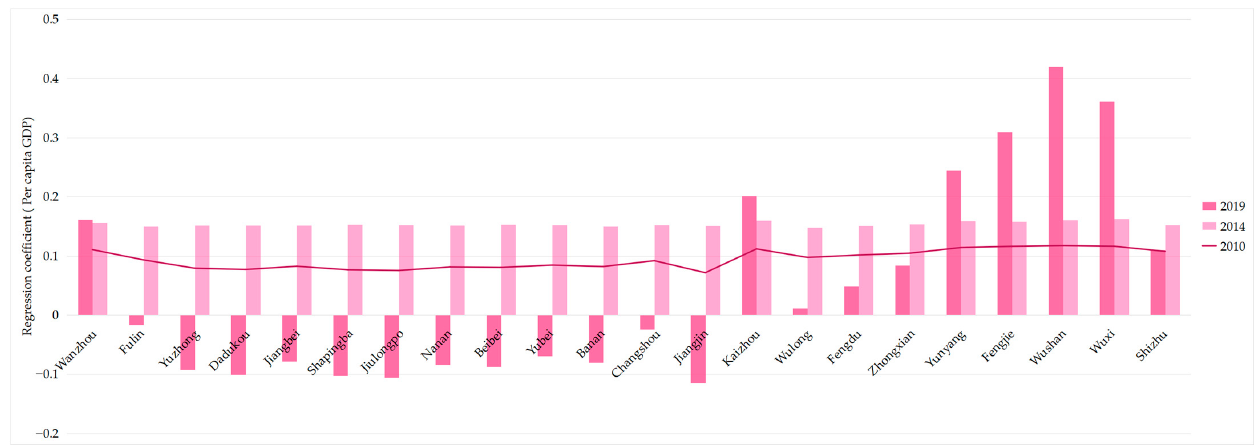
Figure 15. Changes of regression coefficient of E-UDI in the Three Gorges Reservoir Area (Chongqing section). Sources: Calculation results of the GWR model from the economic dimension.